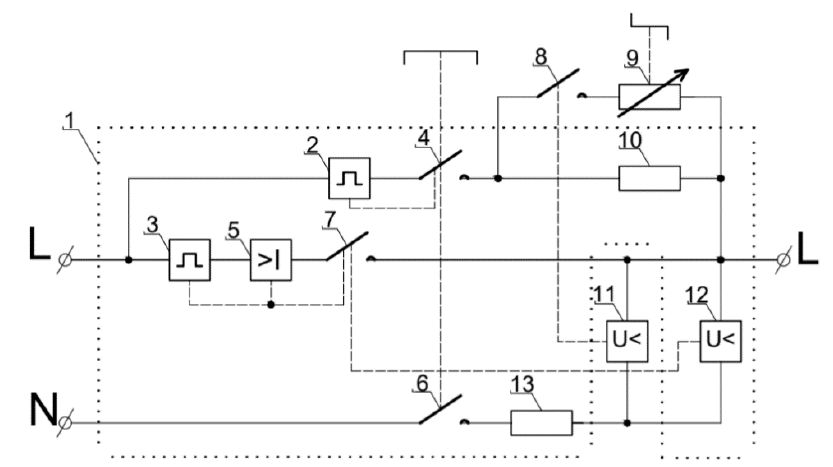
Figure 5. A scheme of the new SCB for lowered supply voltages.